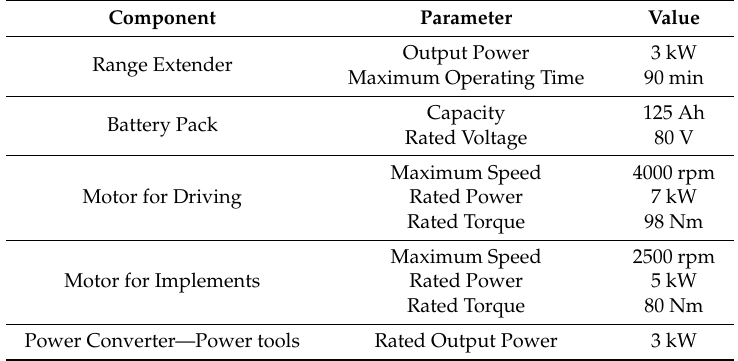
Table 2. Main component parameters of the Re-EV.